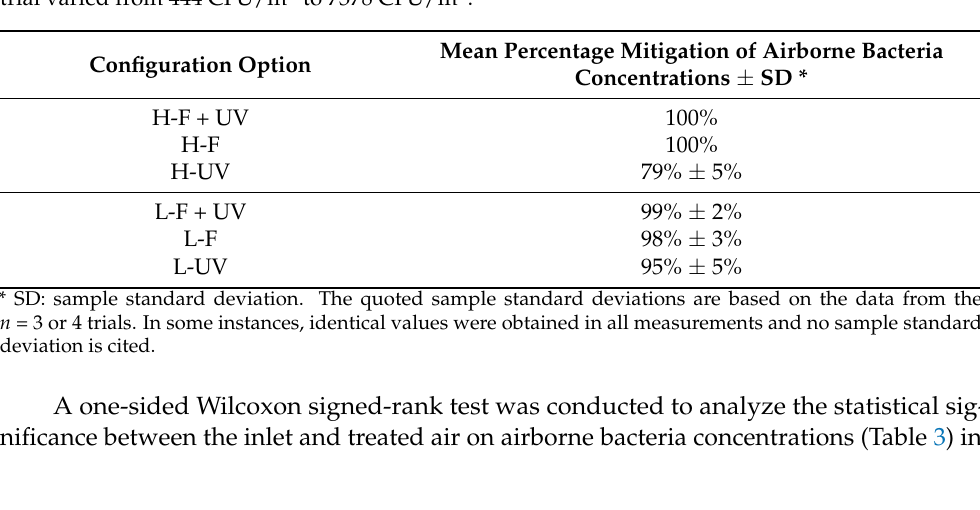
Table 2. Summary of the removal of viable airborne bacteria from the air. The performance metric is the percent reduction defined as the relative difference between inlet and treated concentrations under different configuration options. The percentage is the average of three or four trials conducted for each configuration. The loading of average airborne bacteria concentrations in the inlet air of each trial varied from 444 CFU/m 3 to 7378 CFU/m 3